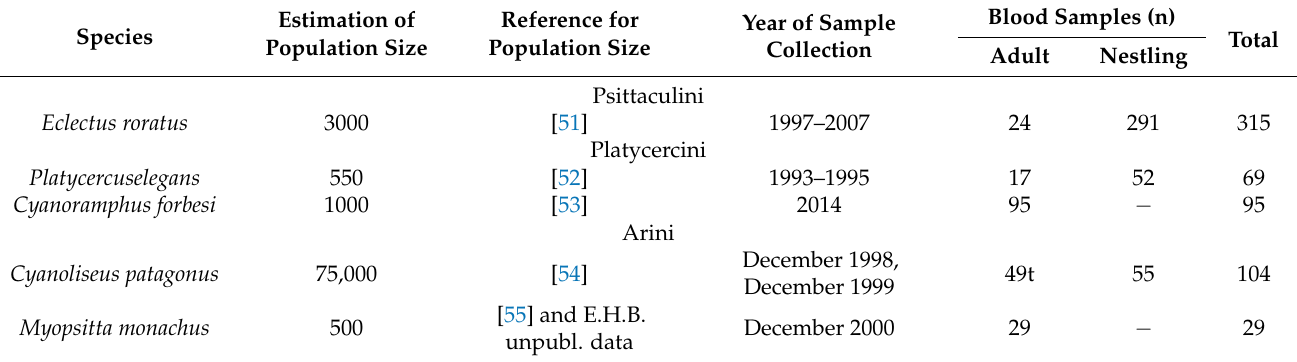
Table 1. Details on blood samples from five wild populations of Psittaciformes in this